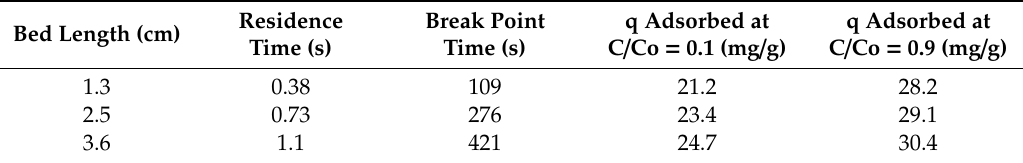
Table 1. Adsorption performance of hematite powder as a function of bed length at T = 25 ◦ C.